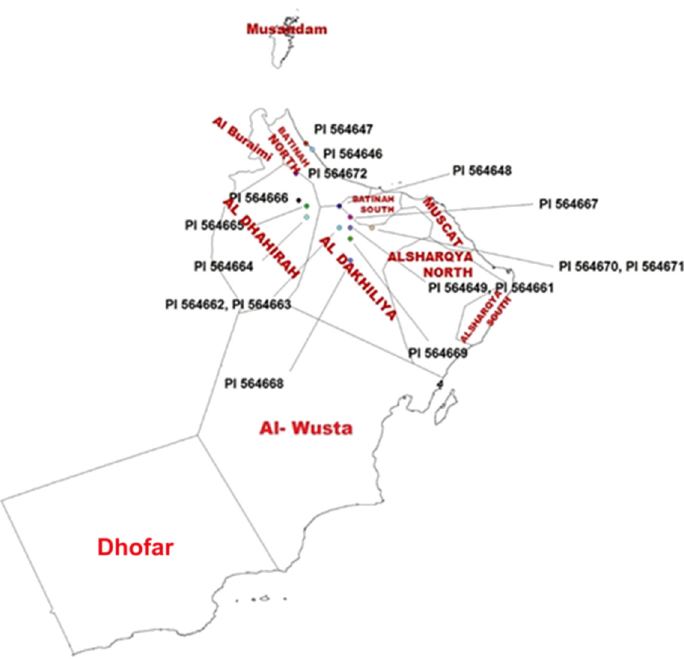
Figure 1: Locations of 16 indigenous barley ( Hordeum vulgare L. ) USDA accessions in fi ve di ff erent governorates of